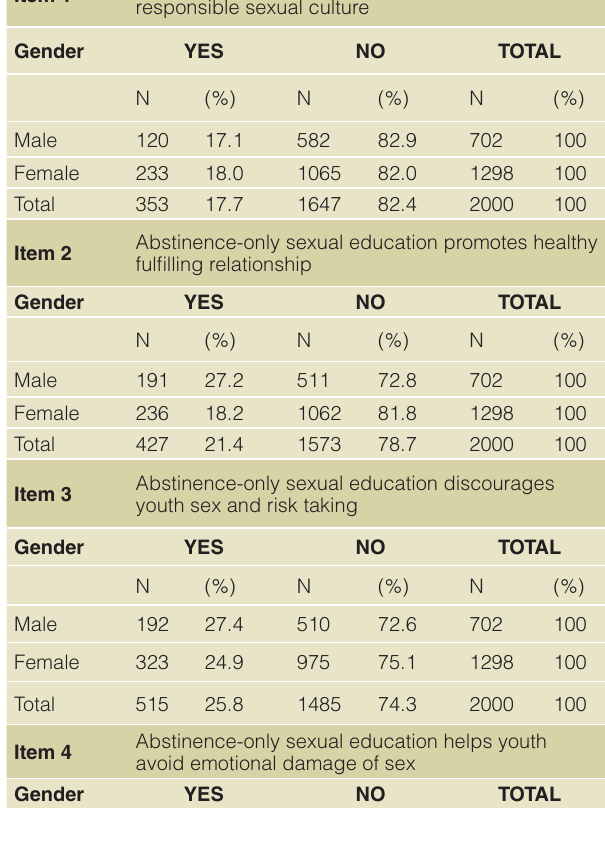
Table 8. Perspective of adolescents according to gender on the advantages of abstinence-only sexual education. Item 1